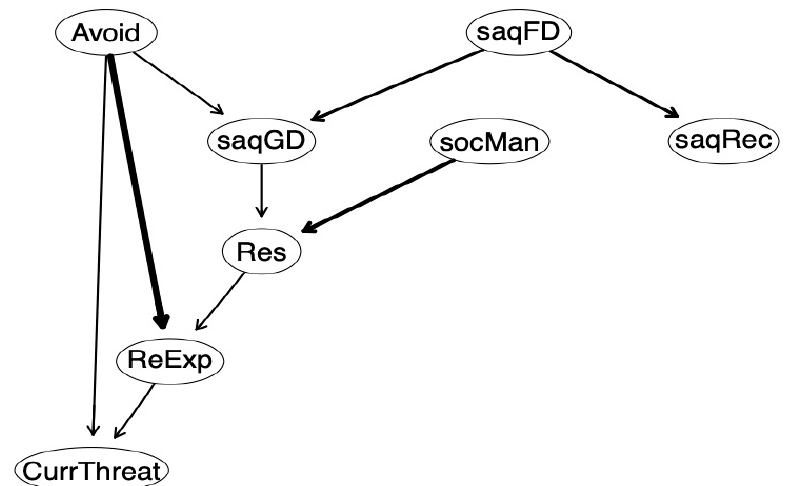
Figure 2. Estimated network of the Bayesian DAG model. Note. Edge (relation between variables) thickness reflects the importance of edges in the model regarding model fit. ReExp = PTSD symptoms of re-experiencing, Avoid = PTSD symptoms of avoidance, CurrThreat = PTSD symptoms of perception of current threat, socMan = sense of coherence-revised subscale manageability, Res = resilience, saqGD = social acknowledgment subscale general disapproval, saqFD = social acknowledgment subscale familial disapproval, saqRec = social acknowledgment subscale recognition.